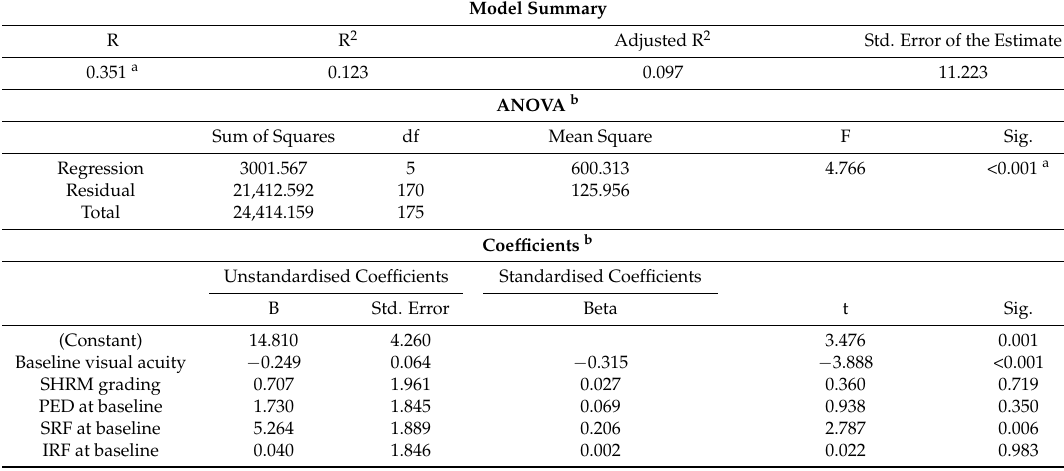
Table 3. Multiple regression model to demonstrate the effect of visual acuity and morphological features at baseline on the degree of change in visual acuity after one year of intravitreal aflibercept injections.